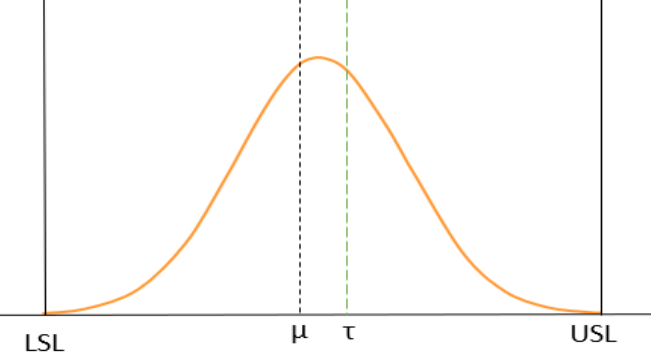
Figure 5. Process capability control analysis.